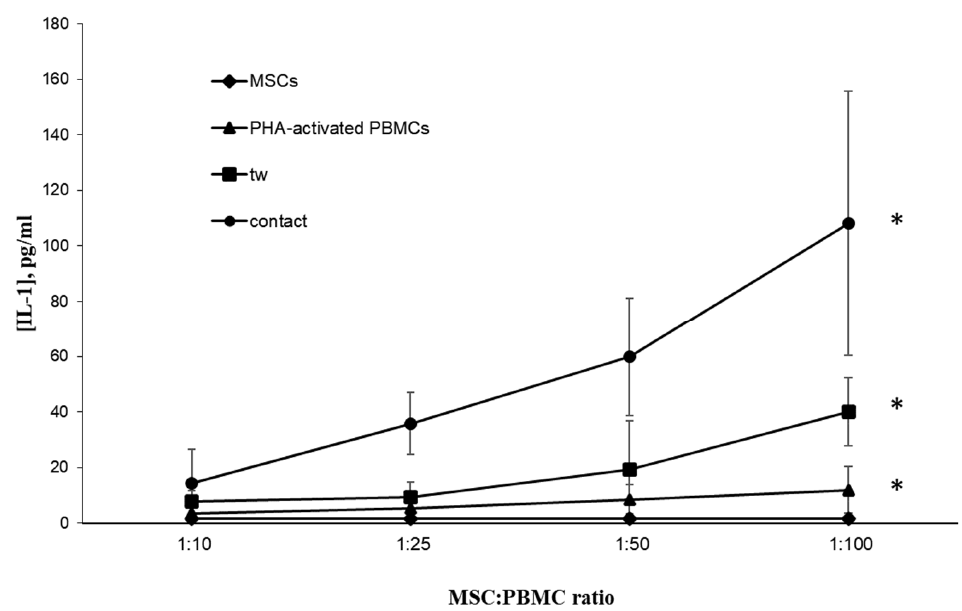
Figure 5. IL-1 concentration in conditioned media of separate MSC and activated PBMC cultures or contact and noncontact (tw) co-cultures. Data are shown as mean ± std; t -test, * reliability of differences at p < 0.05. Three unrelated donors per cell type were used.